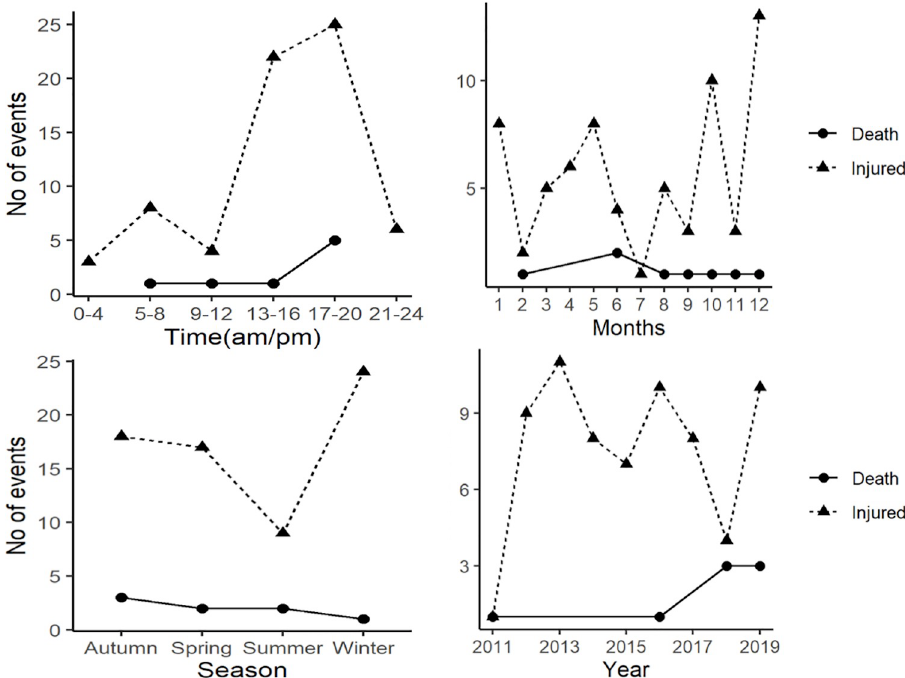
Fig 3. Temporal distribution of HWCs in PLSTK districts during 2011 to 2019 showing time month, season and year of the events.